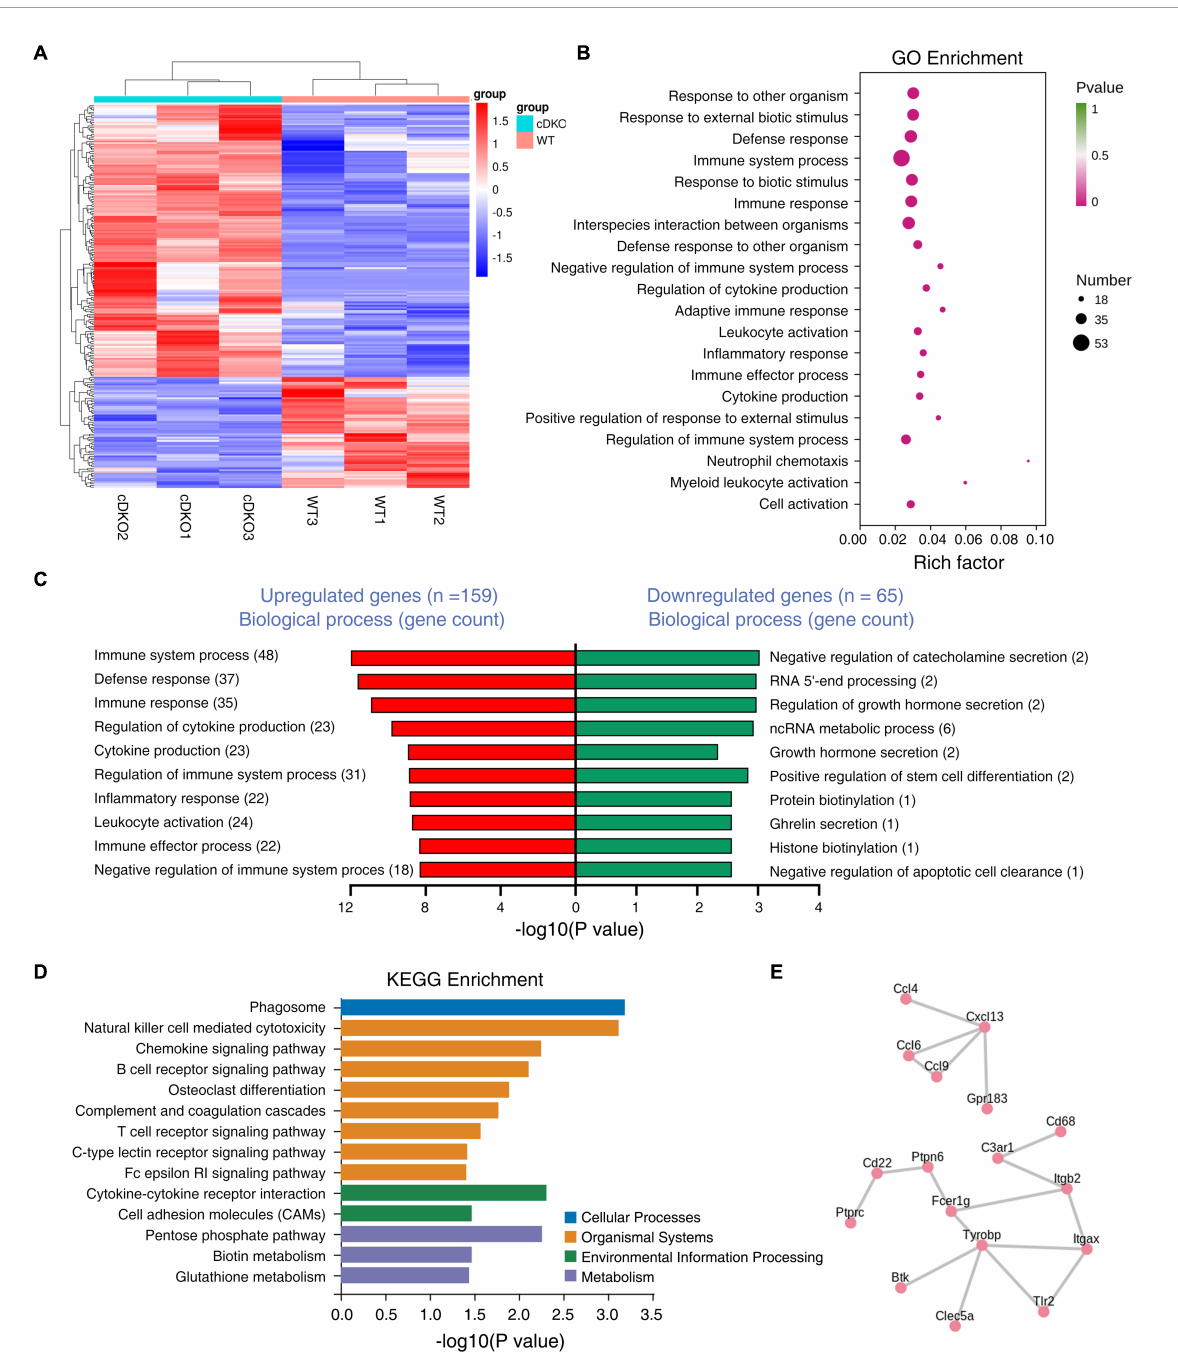
FIGURE4 Differentially expressed genes (DEGs) in the cortex of 2-month-old PS cDKO mice. (A) RNA sequencing data in a heatmap and hierarchical clustering. The 159 up- and 65 down-regulated DEGs were used to generate the heatmap. Upregulated genes are indicated in red, downregulated genes are indicated in blue, n = 3 per group. (B,C) GO enrichment analysis of DEGs from 2M animals. Bubble plots showing the top 20 GO biological processes (B) and the top GO biological processes for DEGs upregulated and downregulated are ranked by the number of gene counts (C) . (D) Kyoto Encyclopedia of Genes and Genomes (KEGG) pathways enrichment analysis for DEGs upregulated in the cortex of cDKO mice compared with control mice. Distribution of the KEGG pathway categories were assigned into four categories: cellular processes, organismal systems, environmental information processing and metabolism. (E) Protein-protein interactions (PPIs) network analysis of DEGs in the cortex of cDKO